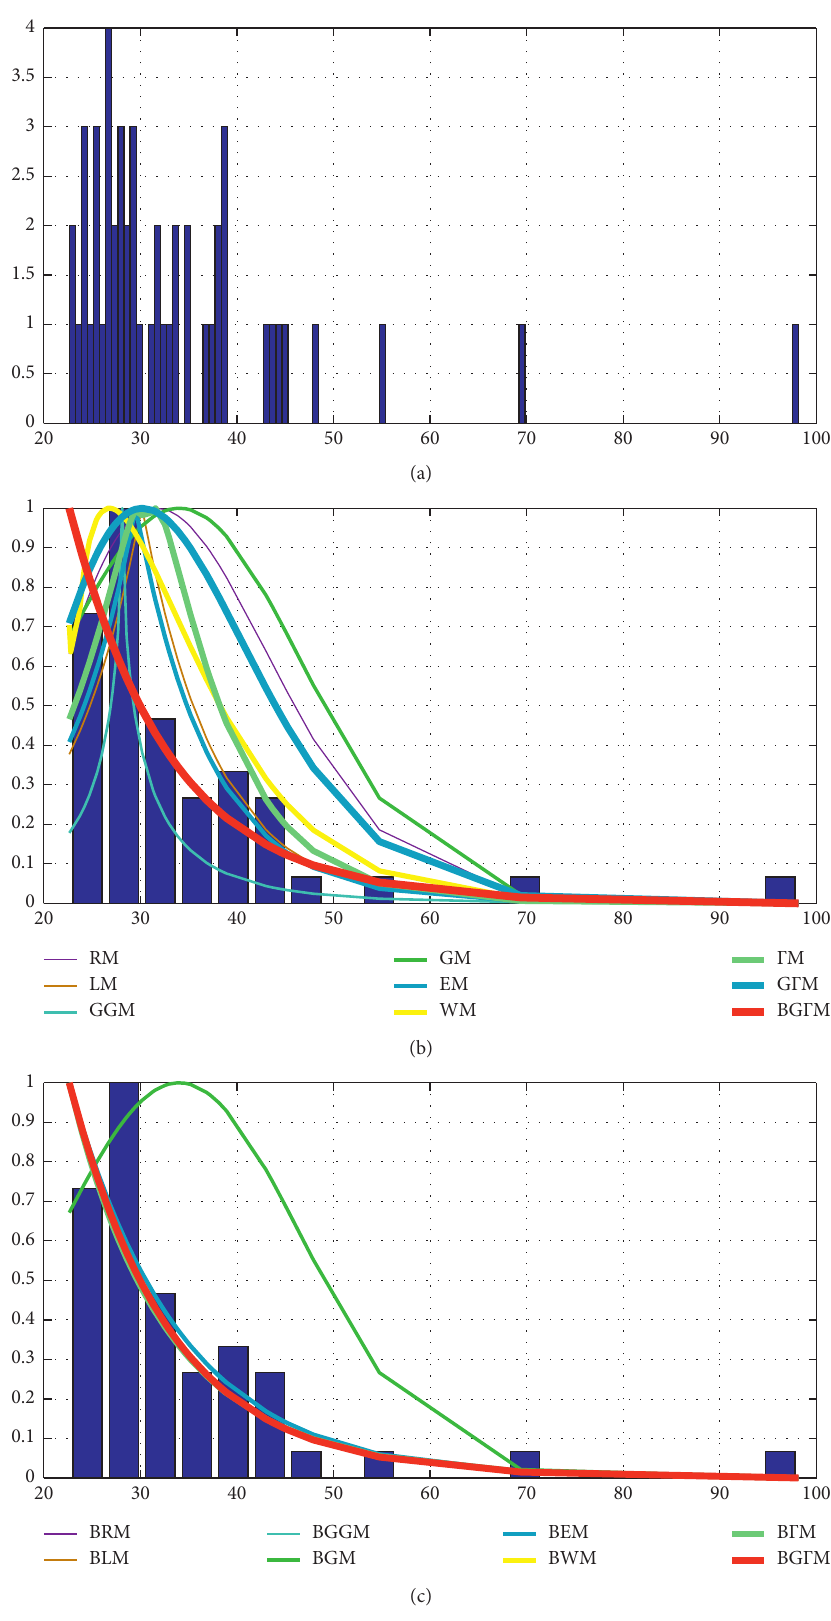
Figure 8: The estimated histogram. (a) The histogram of the yearly maximum wind speed data; (b) the estimated histogram of RM, LM, WM, GM, EM, GGM, Γ M, G Γ M, and G Γ M; (c) the estimated histogram of BRM, BLM, BWM, BGM, BEM, BGGM, B Γ M, and BG Γ